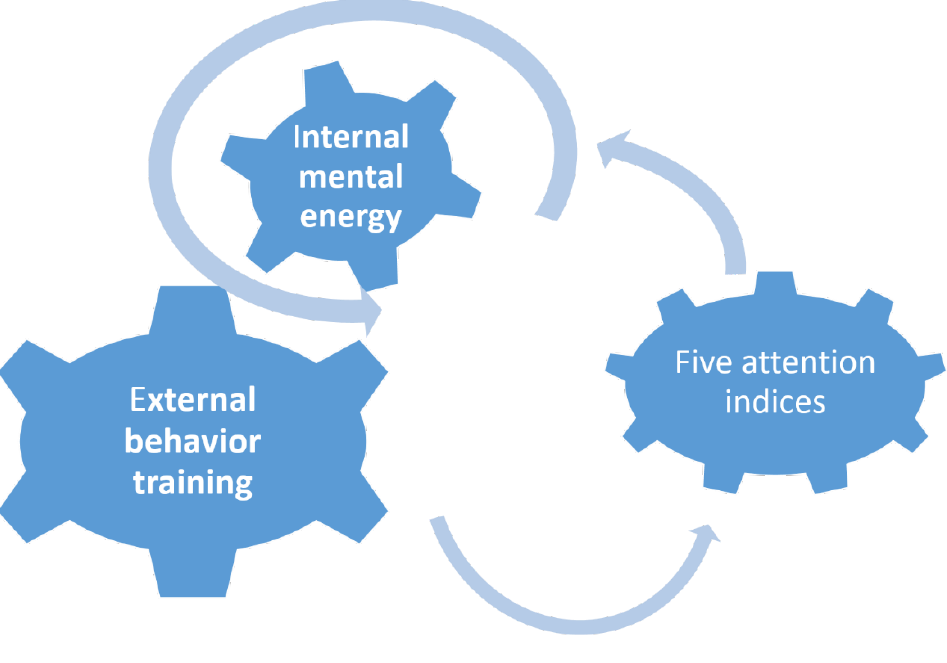
Figure 1. Attention training model.